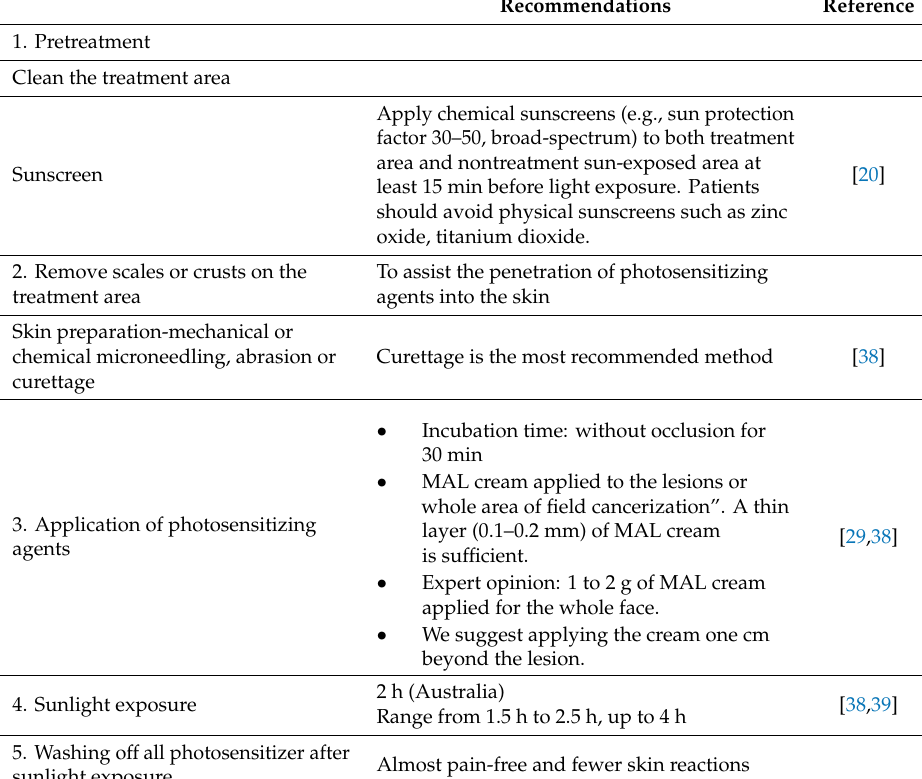
Table 2. Guidelines of dPDT on actinic keratosis from di ff erent consensus